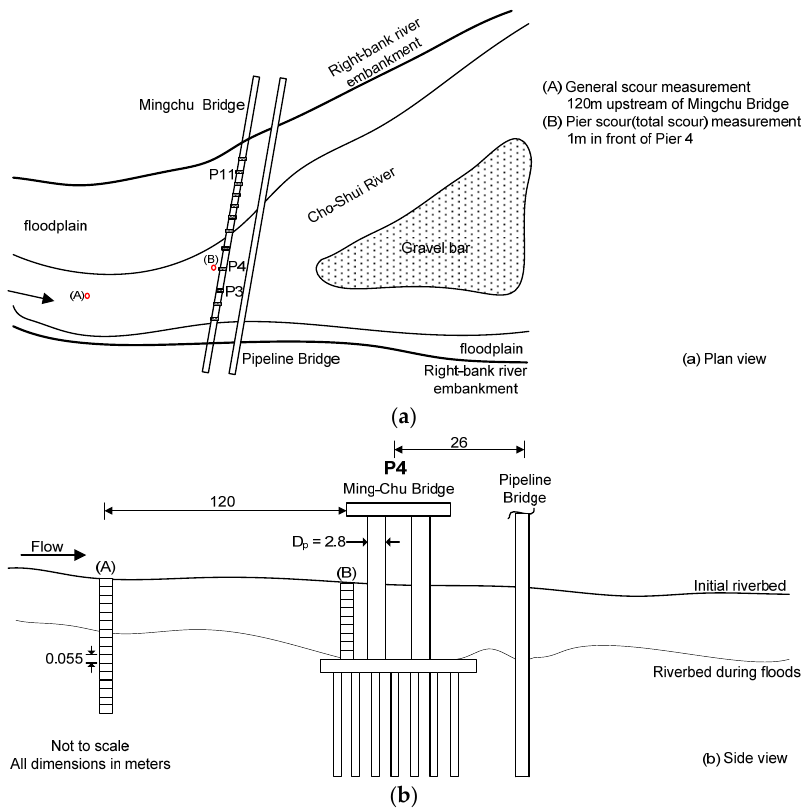
Figure 6. Schematic site plan of the Mingchu Bridge for the installation of numbered-brick columns ( a ) Plan view; ( b ) Site view.